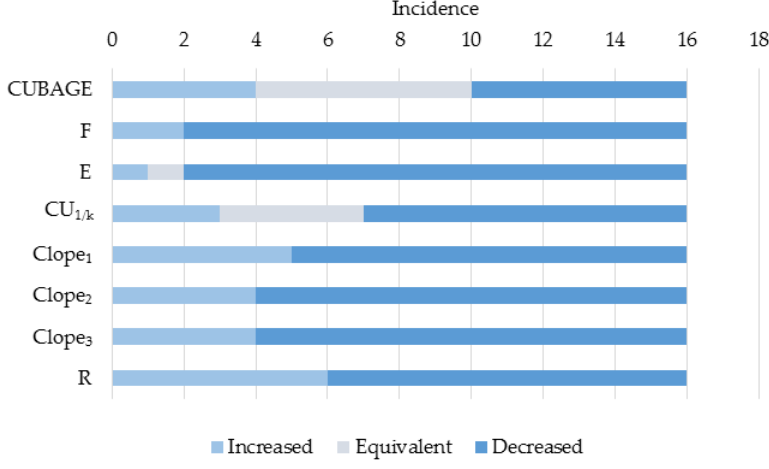
Figure 7. The number of incidences of increased, equivalent, and decreased performances in both NMI and ARI when the number of clusters changes from pre-known to unknown in the k -modes